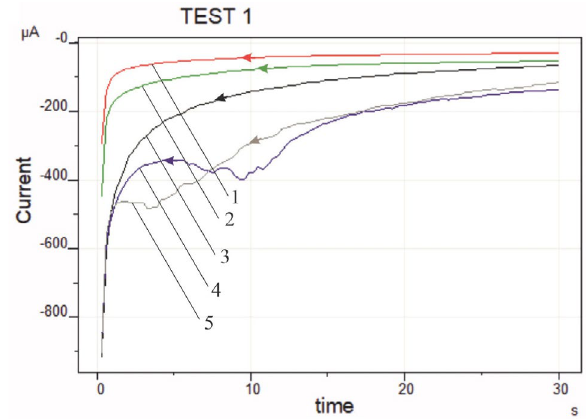
Fig . 7 . Current-time curves of the electrodeposition of molybde- num on Pt in electrolyte consists of 0.1 M Na 2 MoO 4 2H 2 O + 0.007M C 4 H 6 O 6 at T = 295 K at room temperature and at different deposi- tion potentials; 0,047; 0.03; –0.06; –0.09; and –0.1 V vs. Ag/AgCl.